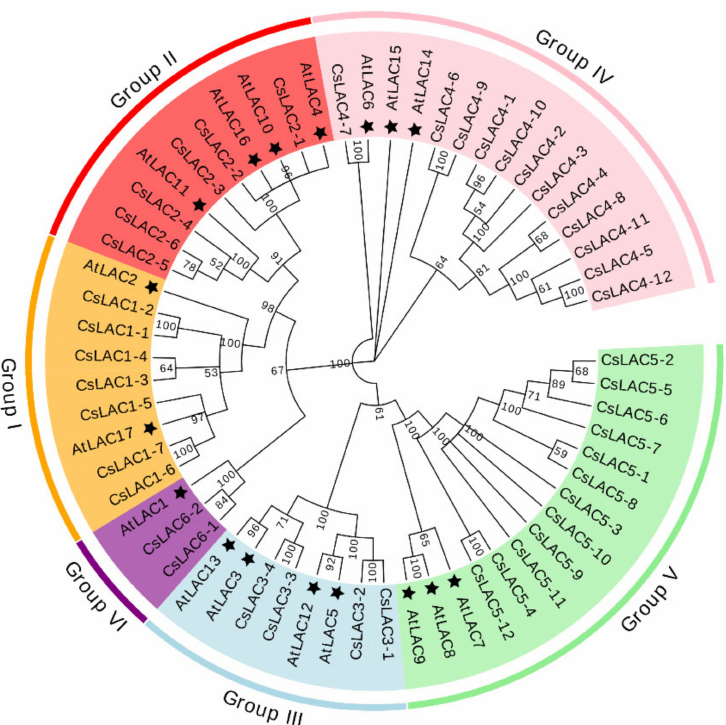
Figure 1. Phylogenetic analysis of Arabidopsis and Camellia sinensis LAC genes. Phylogenetic tree